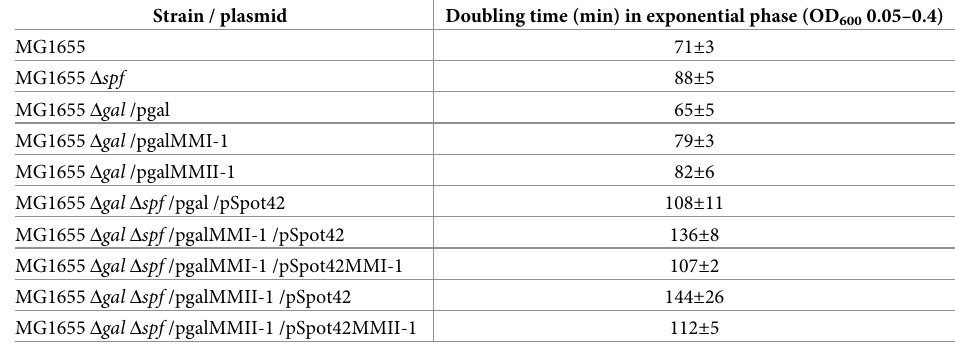
Table 1. Doubling time of various gal and spf mutants in M9-galactose